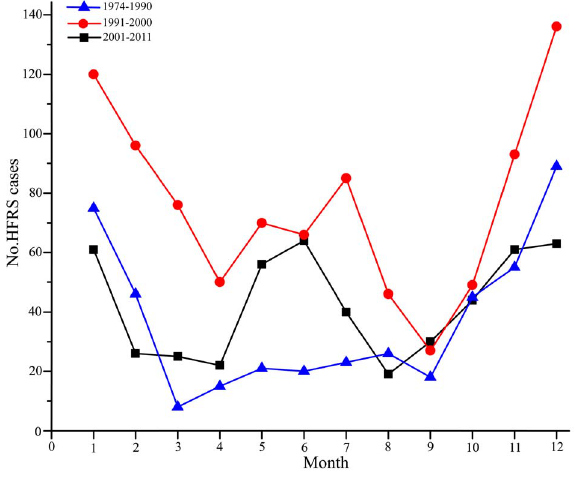
Figure 1. Incidence of HFRS in Longquan. Annual numbers and incidence (cases/100,000 population) of HFRS reported during 1974– 2011 in Longquan city, Zhejiang Province, China.